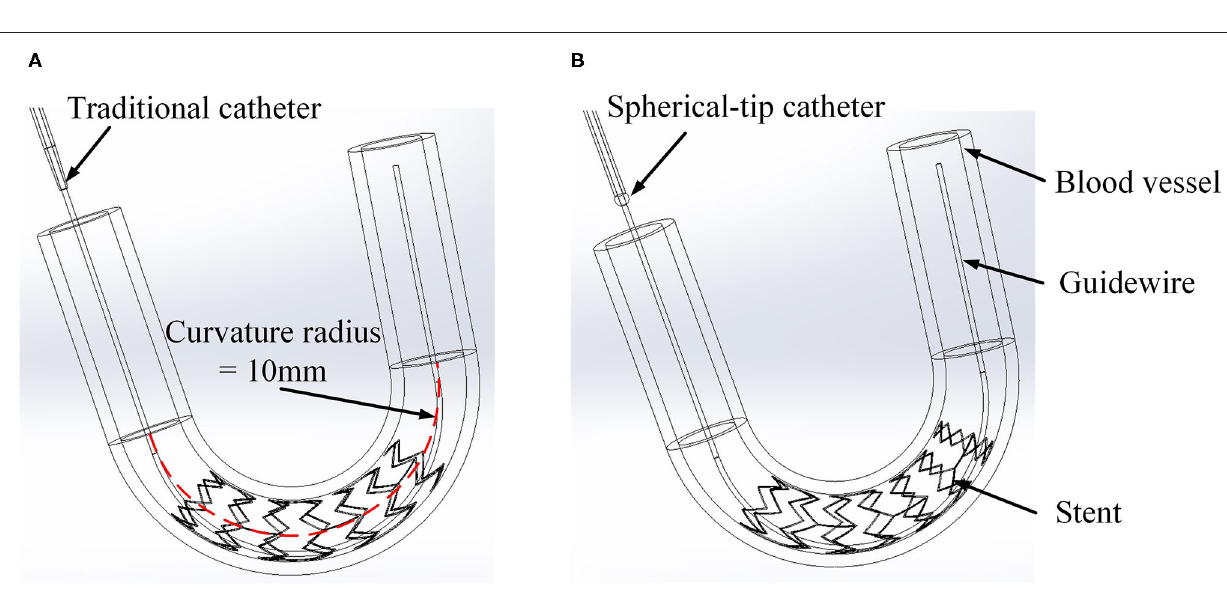
Frontiers in Physiology |